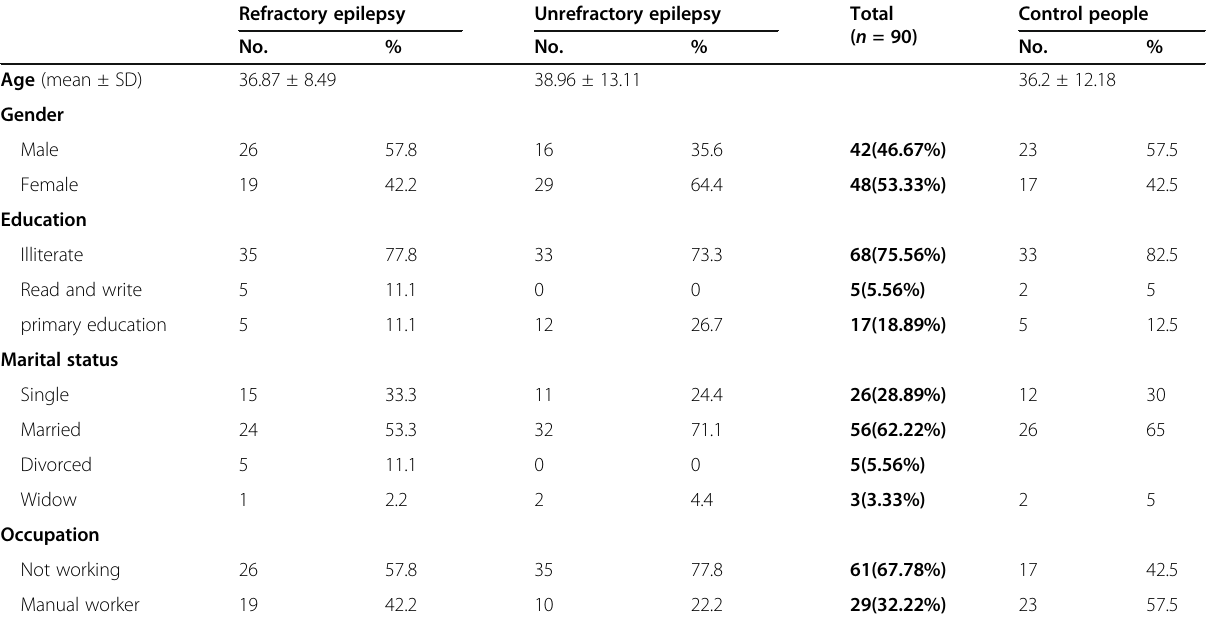
Table 1 Sociodemographic data among the studied sample Refractory epilepsy Unrefractory epilepsy